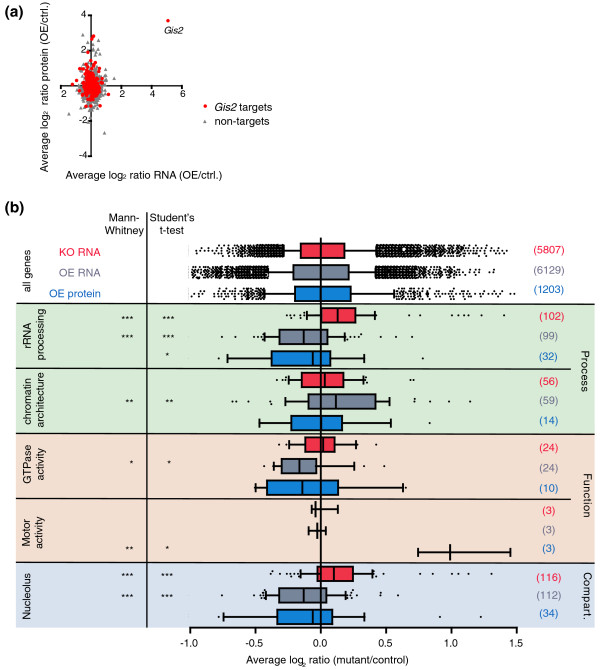
Transcriptome and proteome expression analysis of Gis2p targets. (a) Scatterplot depicting relative changes of protein levels (y-axis) compared to mRNA levels (x-axis). Gis2p targets are shown in red, non-targets in grey. (b) Boxplots depicting relative changes of mRNA levels in gis2Δ cells compared to wild-type cells (knockout (KO) RNA; colored in red), and mRNA (overexpressing (OE) RNA; grey) and protein (OE protein; blue) levels of cells overexpressing GIS2. Whiskers extend from the 10th to the 90th percentile. The distribution of all features is shown on top (all genes). Genes annotated to the GO terms indicated to the left were retrieved from the SGD, and the number of plotted Gis2p target mRNAs/proteins within the respective GO group is indicated in brackets. Asterisks refer to P-values determined in a Mann-Whitney test and Student's t-test with Welch's correction comparing the distribution of Gis2p target genes assigned to specified GO term with the distribution of all measured features: ***P < 0.001; **P < 0.01; *P < 0.05.